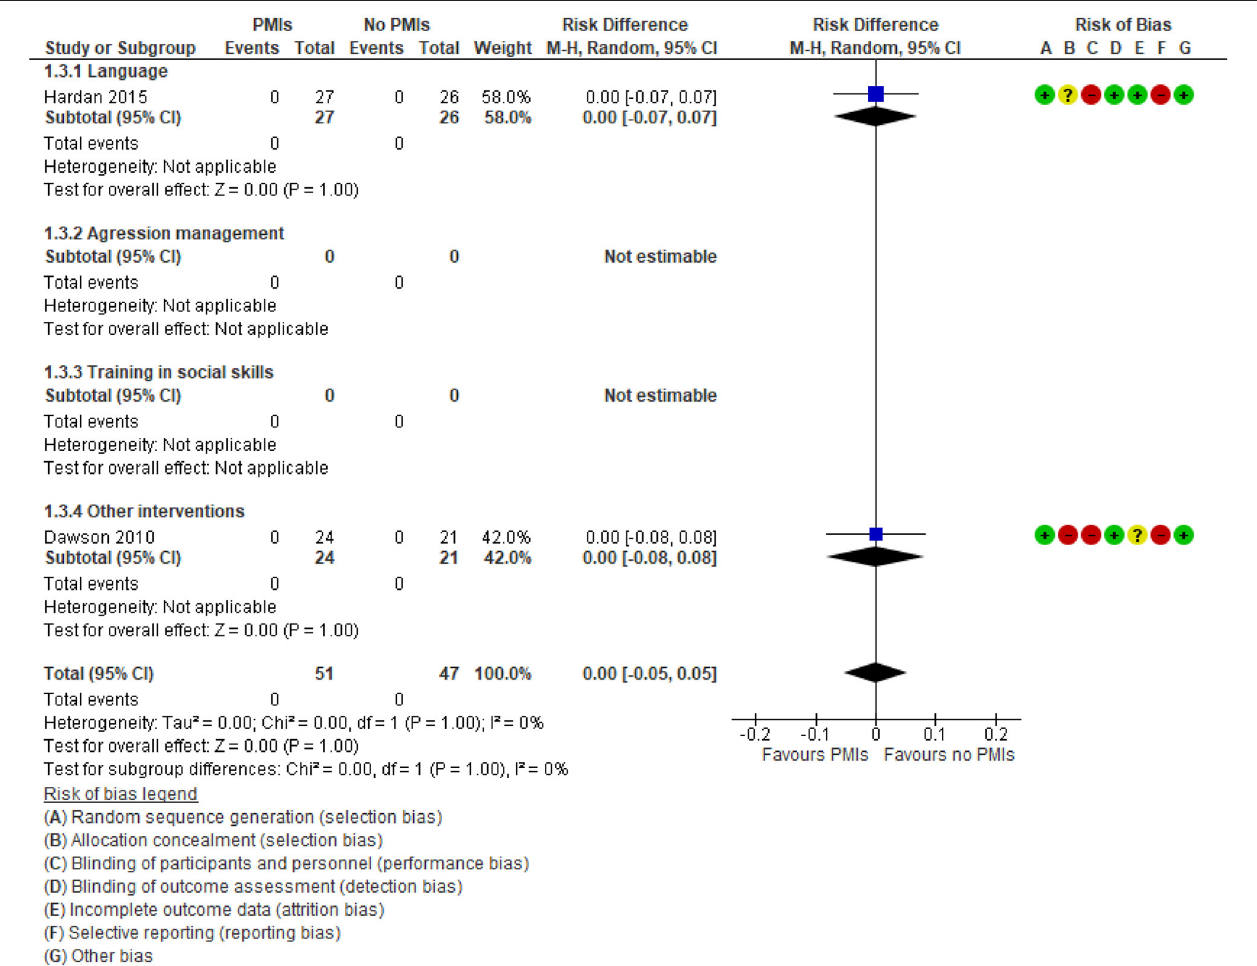
FIGURE 6 | Forest plot of comparison: PMI vs. no PMI, outcome: adverse effects.